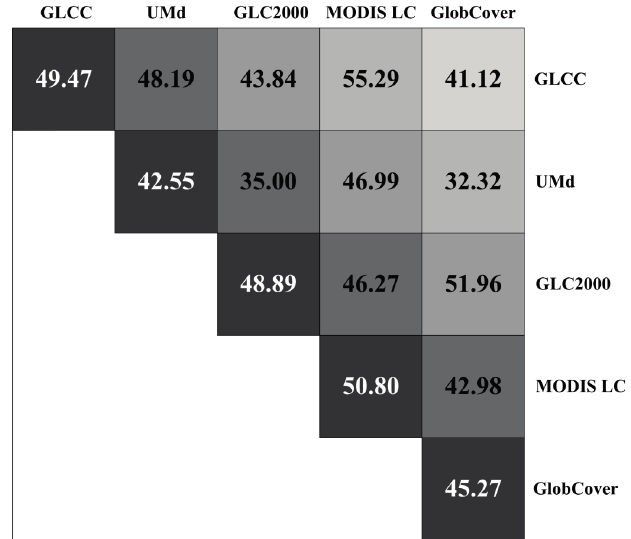
Figure 6. Overall consistencies between GLCC, UMd, GLC2000, MODIS LC, and GlobCover over China. Map-specific consistencies of the compared data sets in China are given along the